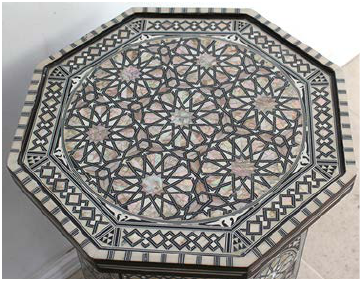
Figure 11-1 traditional geometric patterns Figure 11-2 traditional geometric